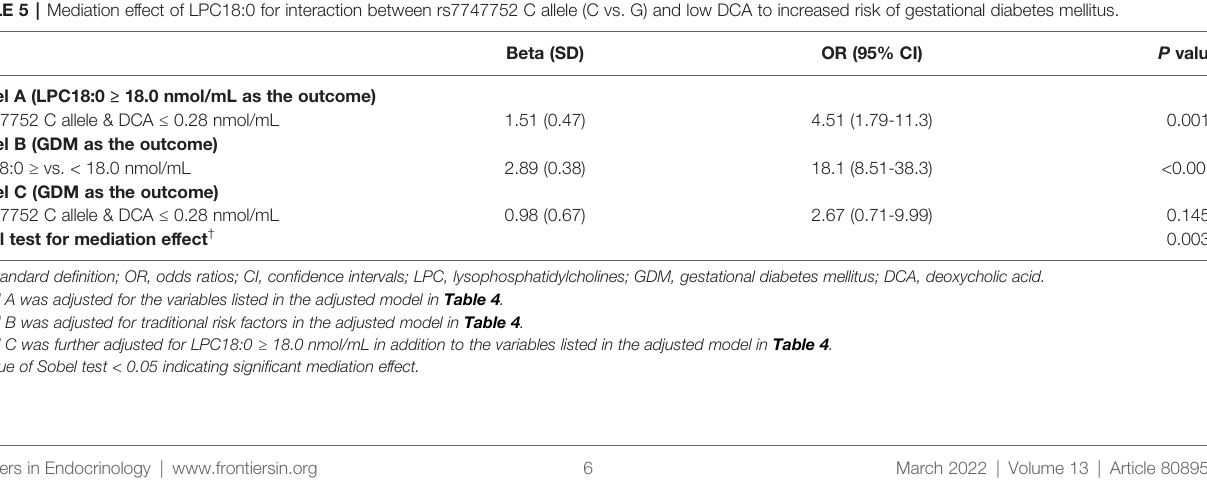
TABLE 5 | Mediation effect of LPC18:0 for interaction between rs7747752 C allele (C vs. G) and low DCA to increased risk of gestational diabetes mellitus.